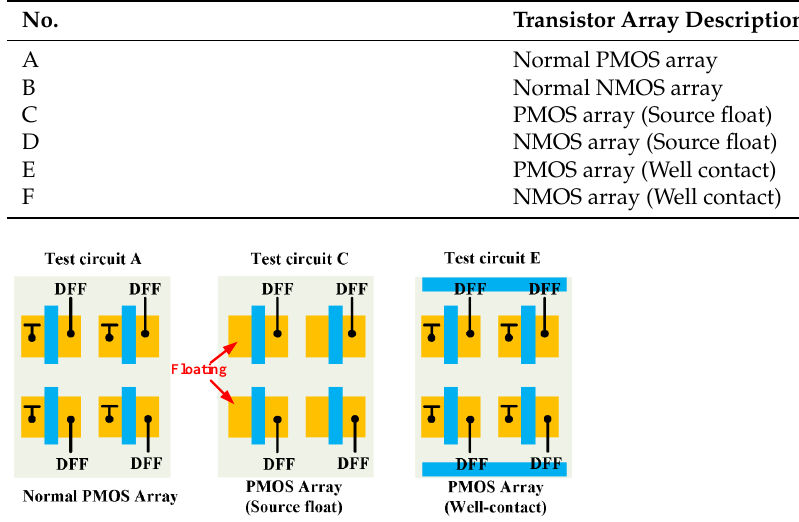
Figure 4. The schematic of the different transistor